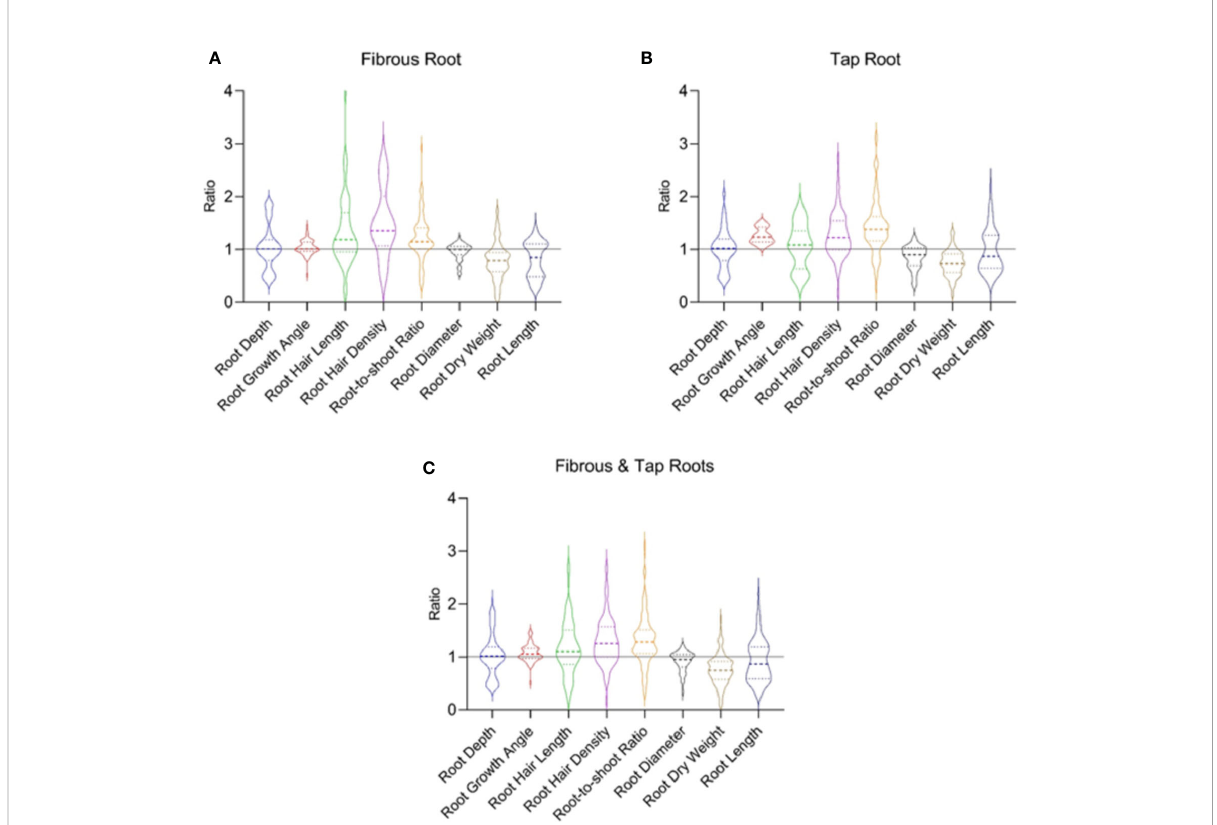
FIGURE 5 The drought response of typical root traits reported in the fi brous root (A) and tap root (B) systems in 70 published papers. (C) shows data from both the fi brous and tap root systems. Ratio is calculated as the value observed under water-stressed condition divided by that under well- watered condition. Data and references are included in Supplementary Table 3 and Supplementary File 3,